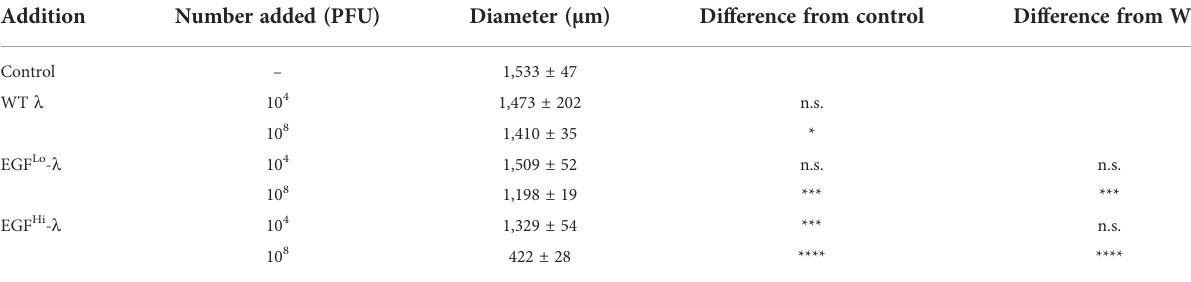
HT-29 spheroids were grown without addition ( ‘ control ’ ) or with addition of phages as described, at the time of addition of the cells onto agarose. Spheroid diameters were measured after growthtod7. Dataare meanvalues±SD(n=3). Statisticalanalysisby2-wayANOVAshoweddifferencesbaseduponphagetypeandnumber added,withindividualcomparisons asnoted.